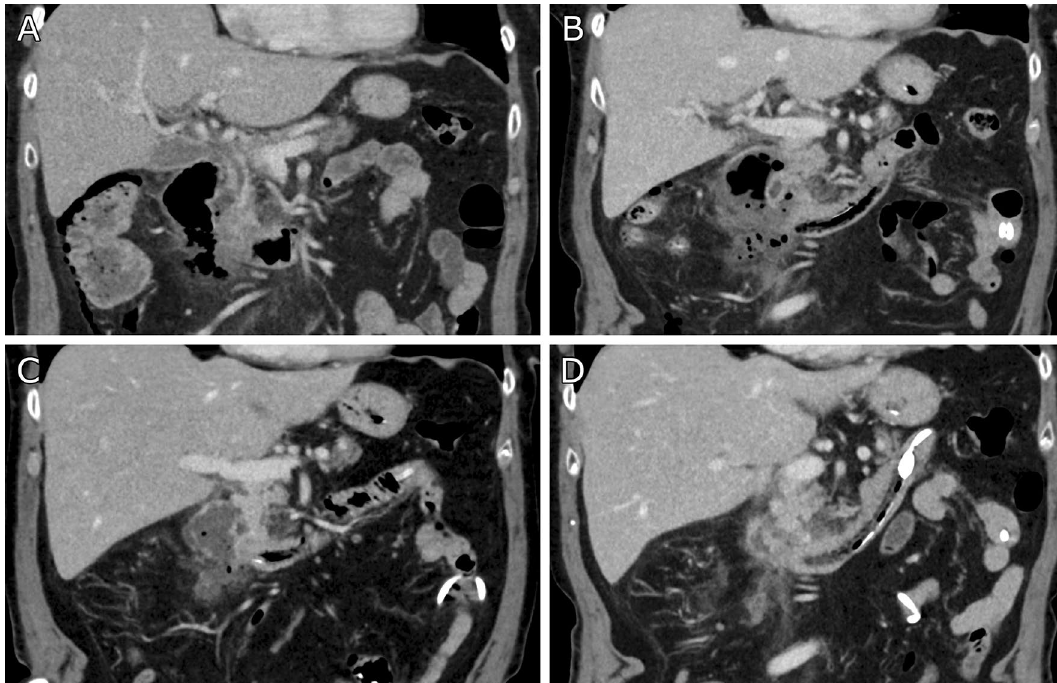
Figure 2. Time course of regression of a retroperitoneal abscess due to perforation of a duodenal diverticulum in patient #8 at initial diagnosis with retroperitoneal gas collections ( A ), with incipient size decrease and regressing gas collections after four days ( B ), further size reduction and decreasing perifocal inflammation after nine days ( C ), and increasingly consolidated state after 15 days ( D ) with endoscopic negative pressure three, four or ten days prior to admission in one patient each (7.7%). Two patients (15.4%) complained of abdominal or epigastric pain for four to five weeks before consulting a physician. Duration of symptoms in one patient (7.7%) suffering from aphagia, gastroesophageal reflux and singultus was not documented. Assessment and documentation of vital signs was performed in all patients showing mostly discrete abnormalities. One patient (7.7%) presented with arterial hypertension, another patient (7.7%) had febrile temperatures up to 38.7° C. Laboratory results showed elevated leukocytes in nine patients (69.2%) and conspicuous C-reactive protein (CRP) values in all but two patients (84.6%). There were no significant differences in leukocytes or CRP values when comparing results from patients treated conservatively, interventionally and surgically respectively. Six (46.2%) patients were treated surgically for contained perforations of a duodenal diverticulum or duodenal ulcer. Surgery was performed on the day of diagnosis in one (7.7%) patient, whereas two (15.4%) patients were operated on the first day and three (23.1%) patients on the second day following diagnosis. Antibiotic therapy in patients that were treated without surgery was initiated on the day of diagnosis in four (30.8%) patients, with a 24-h delay in two (15.4%) patients and started two days prior to diagnosis as calculated therapy in one patient (7.7%). Endoscopic negative pressure therapy was initiated the day of presentation in one patient (7.7%) and one day after admission in the second patient respectively. Figure 2 exemplary presents the course of an intervention- ally treated patient shown by consecutive CT imaging. Table 3 shows a brief overview of treatment parameters, length of stay, adverse events and frequency of read- missions according to therapy. Detailed information on each patient is given in Supplementary Document 1. Length of stay, complications and readmissions. Length of hospital stay disregarding length of stay after readmission was between nine and 22 days. Mean length of stay was 10.2 days for conservative therapy, 20.0 days for interventional therapy and 17 days for surgical therapy. Further information is given in Fig. 3a. None of the patients treated conservatively or interventionally was admitted to the intensive care unit, whereas three (50.0%) patients that underwent surgery required intensive care. There were two readmissions for further inpatient treatment, one following surgical and conservative treatment each, whereas no readmission occurred after interventional treatment. The extent of secondary hospital stay was 29 days for patient #5, who underwent endoscopic transgastric drainage for persistent retrogastric abscess and further antibiotic treatment for infection with Mycobacterium tuberculosis following open abscess evacuation and drain insertion. Patient #13 underwent endoscopic drainage of a persistent retroperitoneal abscess and had fourteen days of rehospitalization after initial conservative treatment. Distribution of complications according to Clavien-Dindo classification of postoperative complications is shown in Fig. 3b. In total, there were nine complications, which were grade I, II and IIIa each, three complica- tions graded IIIb and three complications graded IVa in seven patients, five of whom (83.3%) underwent surgical therapy and two (28.6%) non-surgical treatment. Patient #1 , that underwent open duodenal sewing of the perfo- rated segment, cholecystectomy, repositioning of the herniated stomach and colon and hiatoplasty, had revision